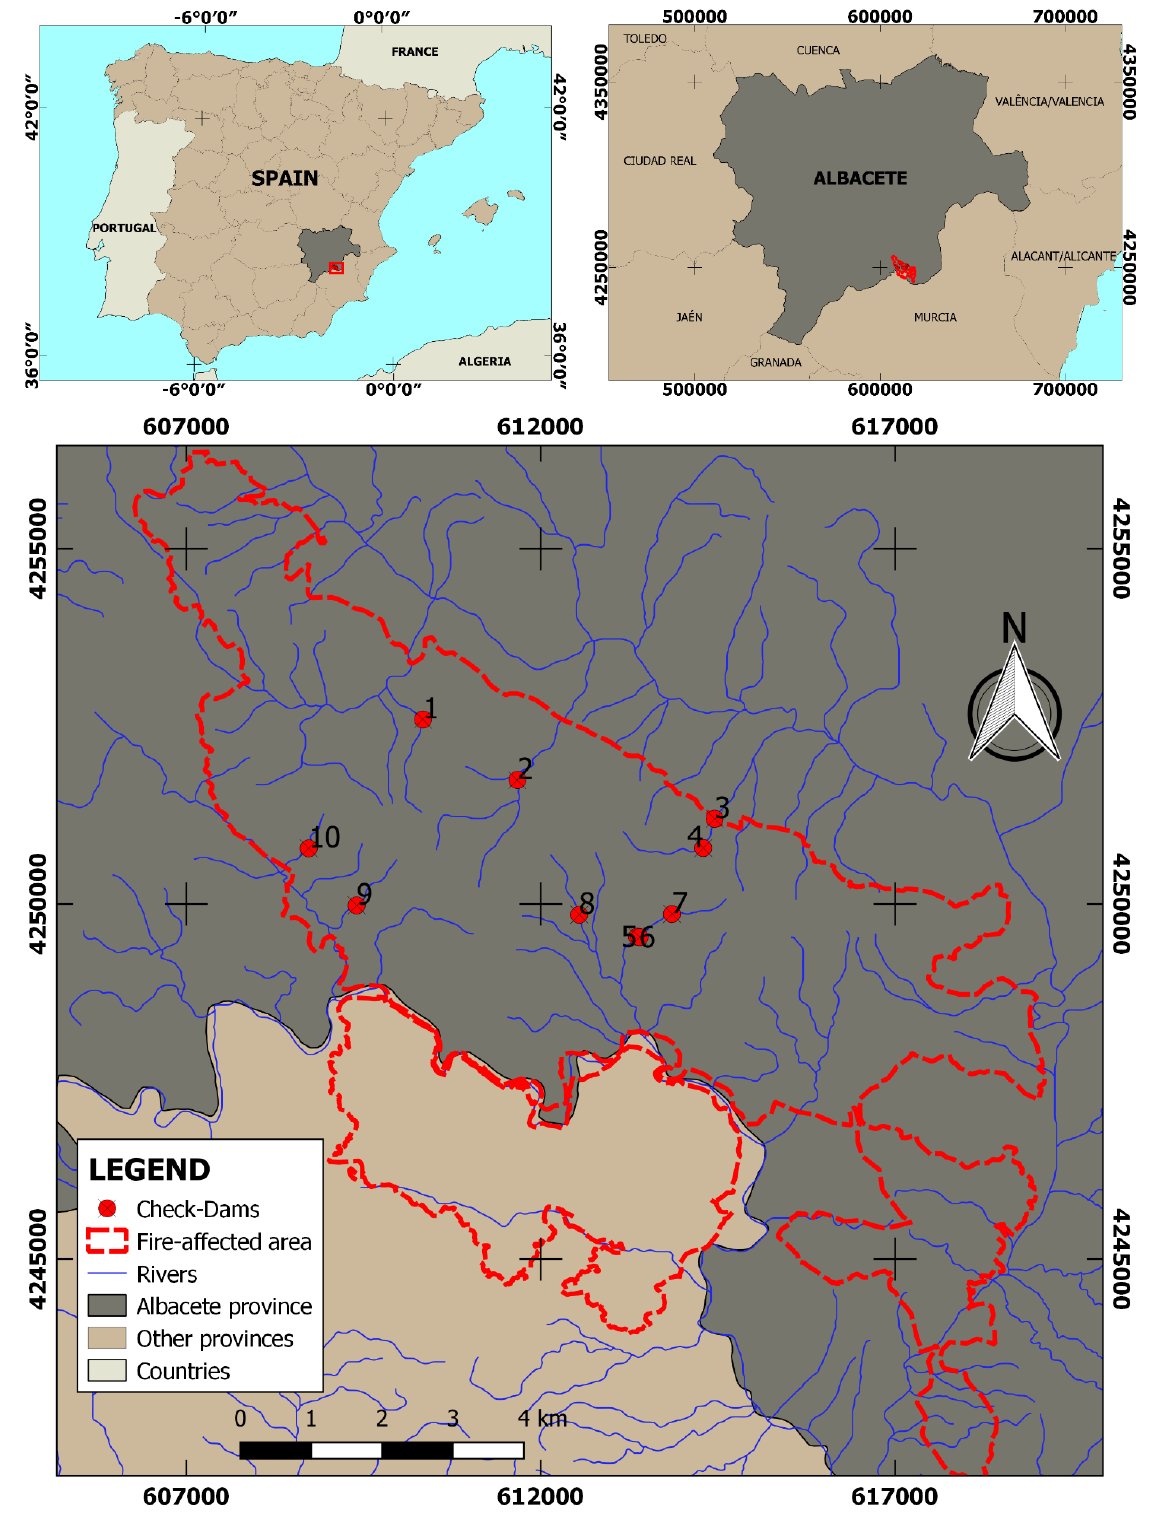
Figure 1. Location and map of the experimental watershed (Sierra de Los Donceles, Castilla La Mancha, Spain) with ten Figure 1. Location (upper) and map (lower) of the experimental watershed (Sierra de Los Donceles, Castilla La Mancha, check dams mapped using aerophotogrammetric and topographic methods. Spain) with ten check dams mapped using aerophotogrammetric and topographic